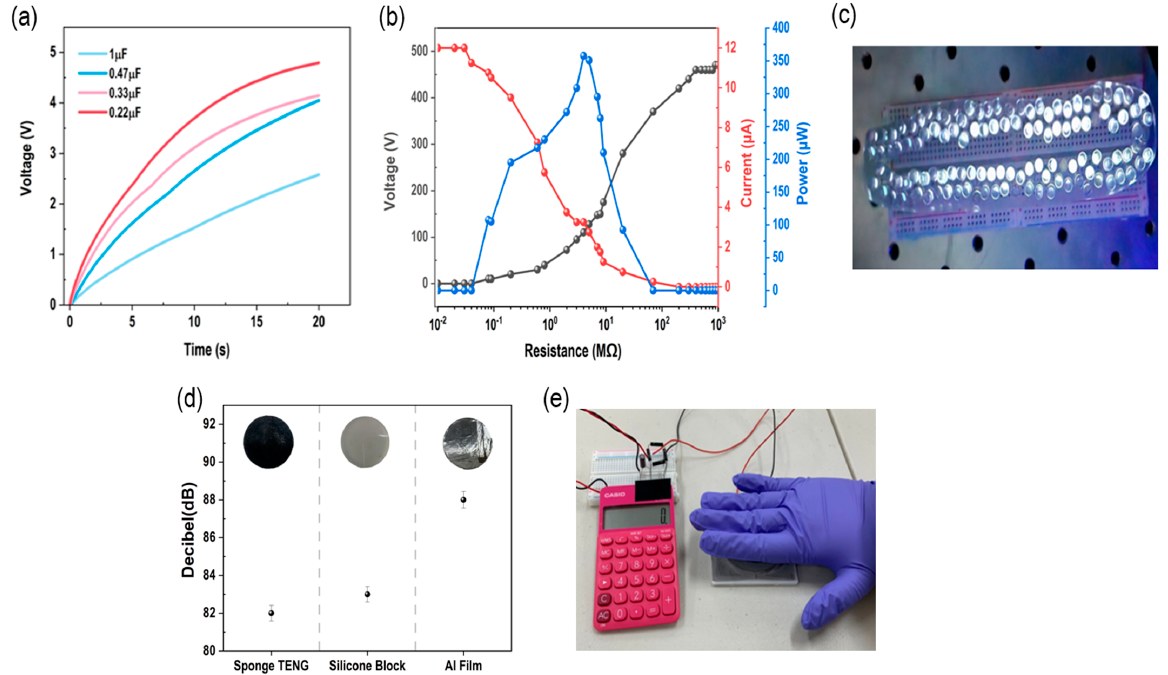
Figure 5. Performance check using FCS-TENG. ( a ) Graph depicting the use of capacitors with different capacitance values (0.22, 0.33, 0.47, 1 µF), ( b ) output performance test at varying external impedance levels, ( c ) 118 white LED lights arranged in a row, ( d ) noise test conducted with three materials (FCS − TENG, silicone block, Al film), and ( e ) calculator-charging test using FCS − TENG.